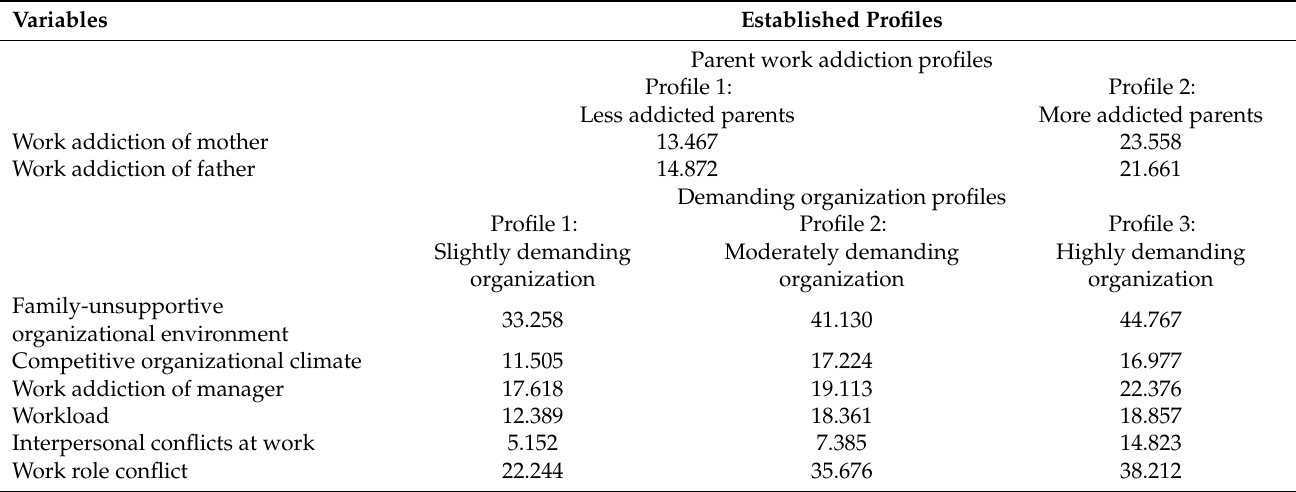
Table 4. Description of the latent